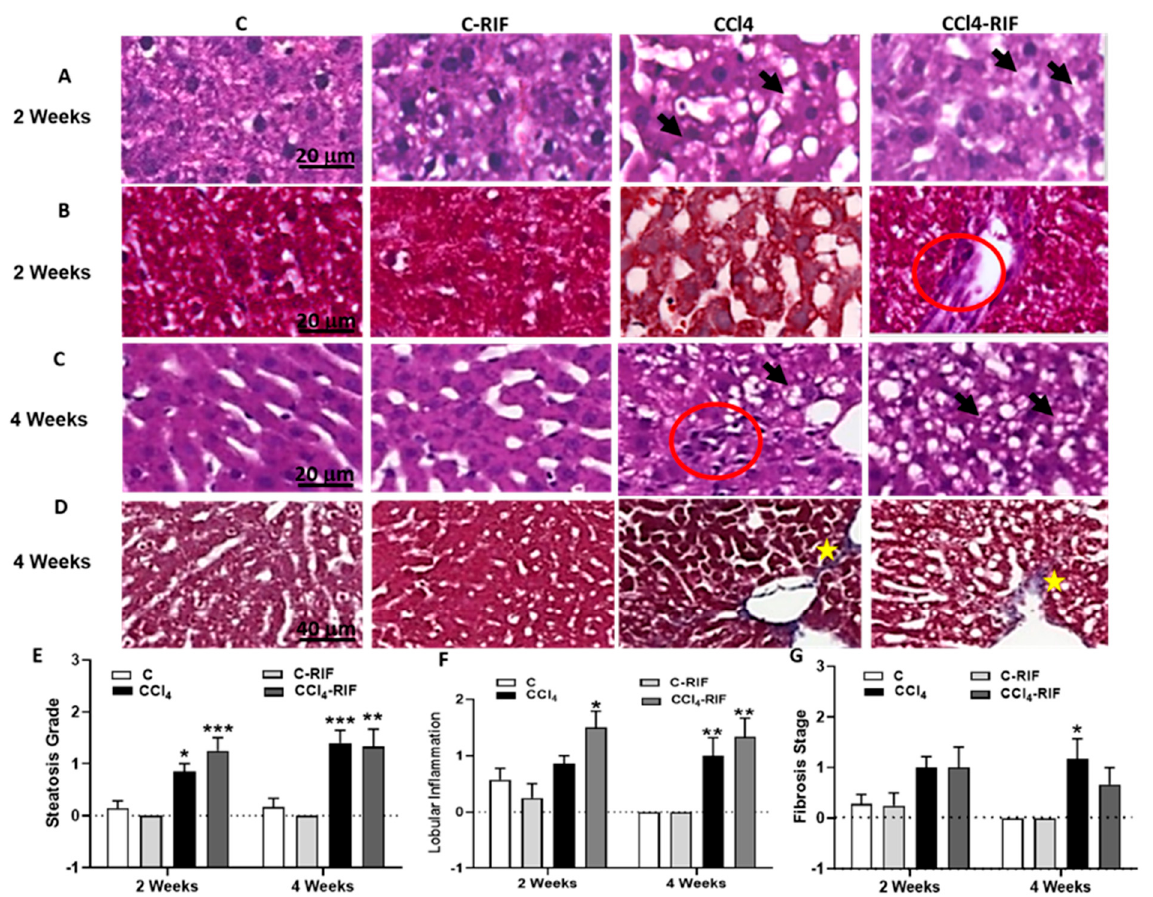
Figure 2. Hepatic damage: lipid deposition, lobular inflammation and fibrosis at 2 and 4 weeks. Representative images of ( A , C ) H&E and ( B , D ) Masson’s stains at 2 and 4 weeks of CCl 4 treatment are shown. In rats treated with CCl 4 , increased lipid deposition was already present at 2 weeks (fat accumulation in liver is indicated with black arrows in ( A , C ); lobular inflammation (red circle in C ) and collagen accumulation (yellow stars in D ), only appeared at 4 weeks. No lesions were observed in control rats. Scale bar is 20 μ m in ( A – C ) and 40 μ m in ( D ). The grade of steatosis, inflammation and fibrosis was determined and is also represented in ( E – G ), respectively. Statistical analysis was carried out with Two-way ANOVA and Tukey’s multiple comparison test. Group effect was significant for the three parameters, but no significant effect for interaction or week of CCl 4 administration was found. Statistic data were F(3,31) = 23.09, p < 0.0001 for steatosis, F(3,31) = 12.63, p < 0.0001 for inflammation and F(3,31) = 6.94, p < 0.001 for fibrosis differences between groups. Values are mean ± SEM of 6 rats per group. Values significantly different from control rats are indicated by asterisks. * p < 0.05, ** p < 0.01, *** p < 0.001. No significant differences between CCl 4 and CCl 4 -RIF groups were found.